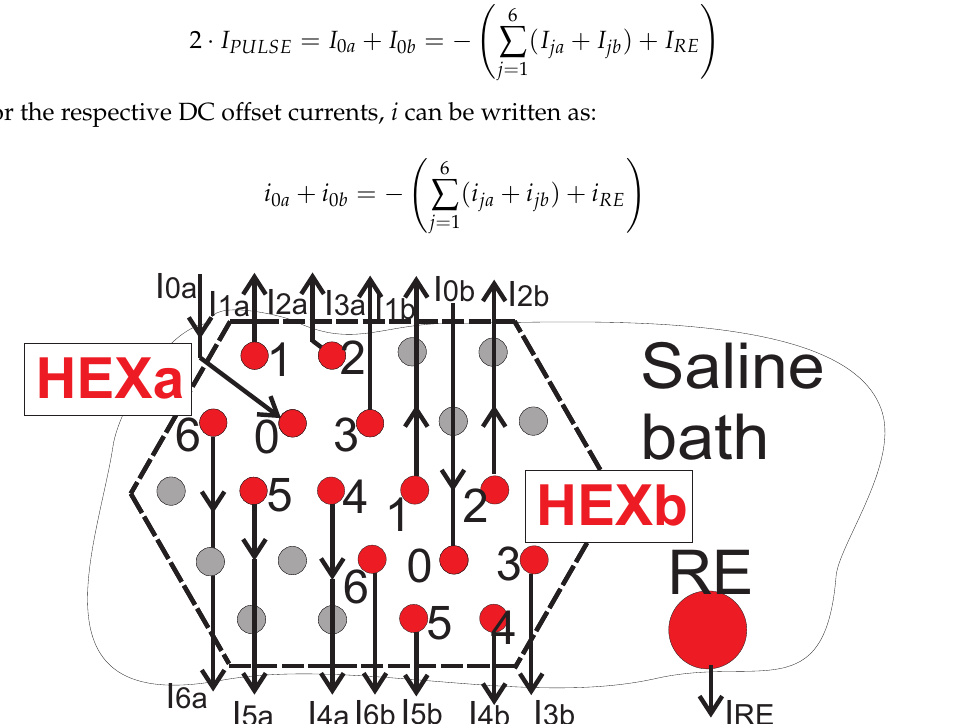
Figure 8. Sketch of a Hex Quasi-monopolar (HQ) return stimulation pattern using two active hexagon (HEXa and HEXb) according to the electrode matrix shown in Figure